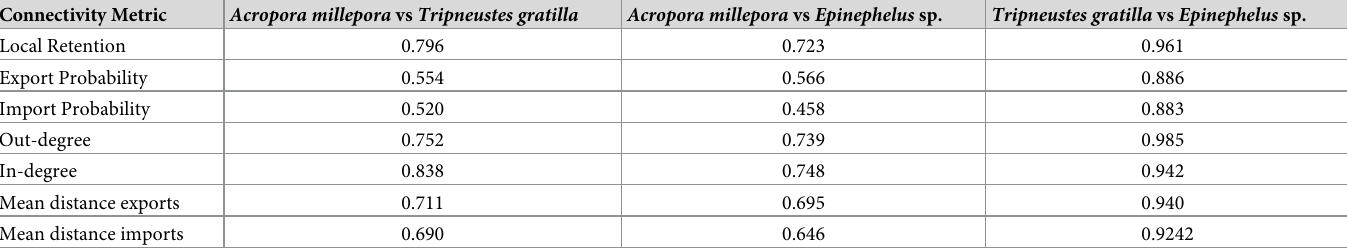
Table 2. Pearson correlation coefficients of the connectivity metric of each reef cell between model organisms. All correlations were significant (p-values <